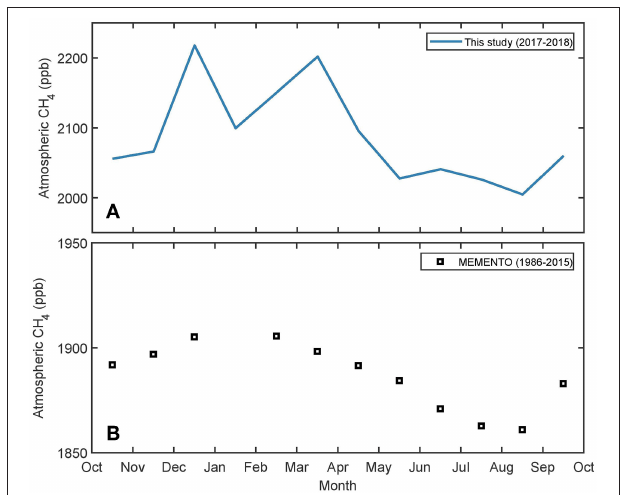
FIGURE 4 | Monthly means of atmospheric CH 4 dry mole fraction from (A) Östergarnsholm station during 2017–2018 (this study), and (B) MEMENTO database in the Gotland Basin obtained between 1986 and